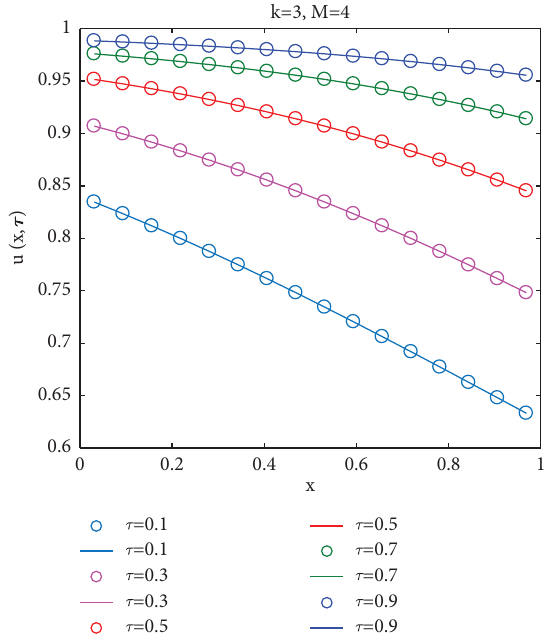
Figure 7: Approximate and exact solution for diferent τ of Example